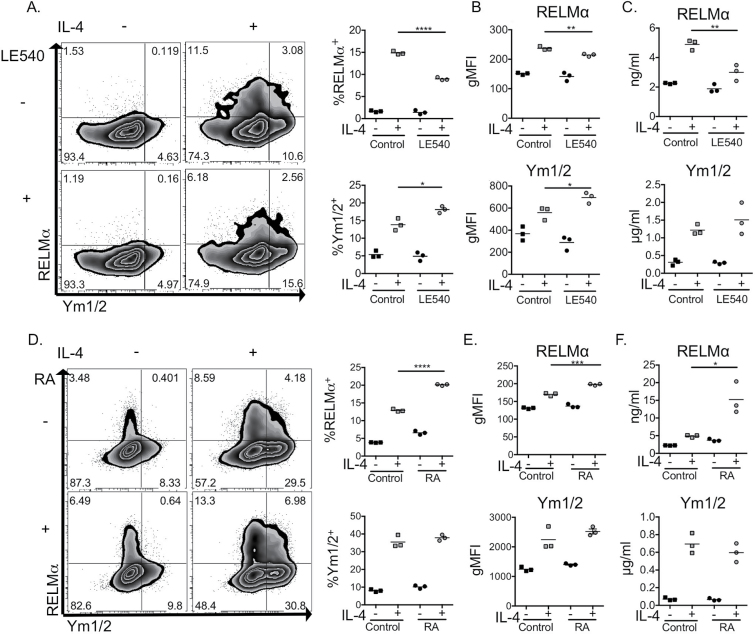
RAR signalling regulates IL-4-driven DC alternative activation. BMDCs were cultured overnight with or without 20-ng ml−1 IL-4 and either the pan RAR antagonist LE540 (A–C), RA (D–F) or vehicle control. RELMα and Ym1/2 protein production was assessed by intracellular staining (A and D), while RELMα and Ym1/2 secretion was assessed by ELISA (C and F). Data are representative of 3 (A–C) and >5 (D–F) independent experiments. Error bars represent triplicate culture wells. *P < 0.05, **P < 0.01, ****P < 0.0001.